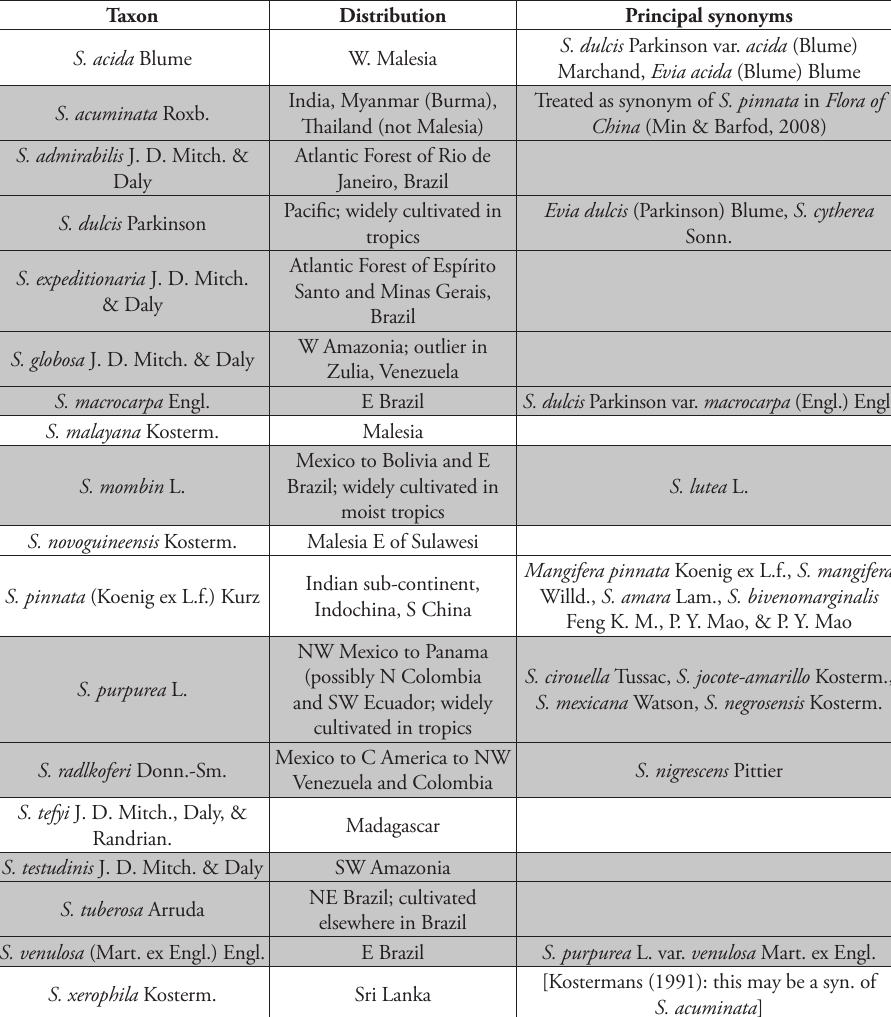
Table 1. The taxa of Spondias accepted in the present treatment (taxa revised herein are shaded).